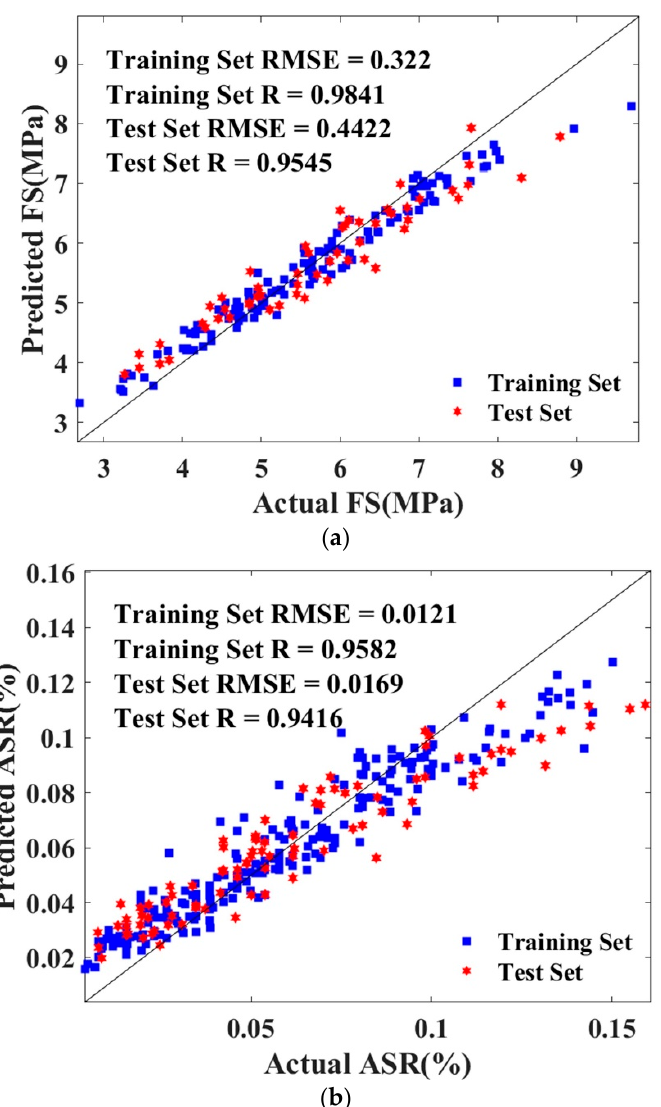
Figure 12. Scatter plot of simulated and actual values of ( a ) FS and ( b ) ASR.